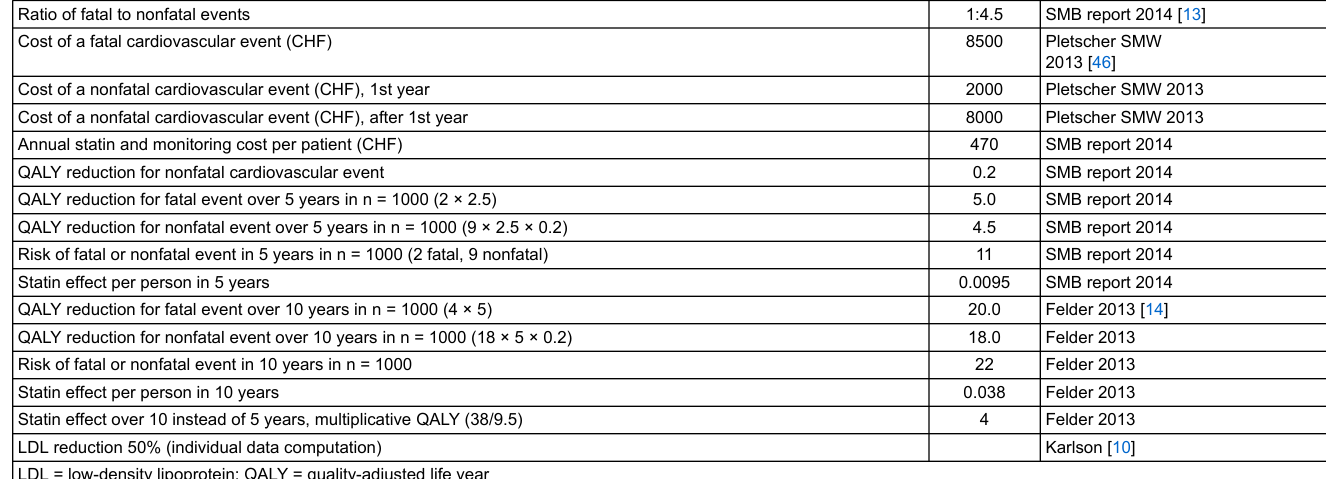
Table S3: Base-case assumptions of the Swiss Medical Board